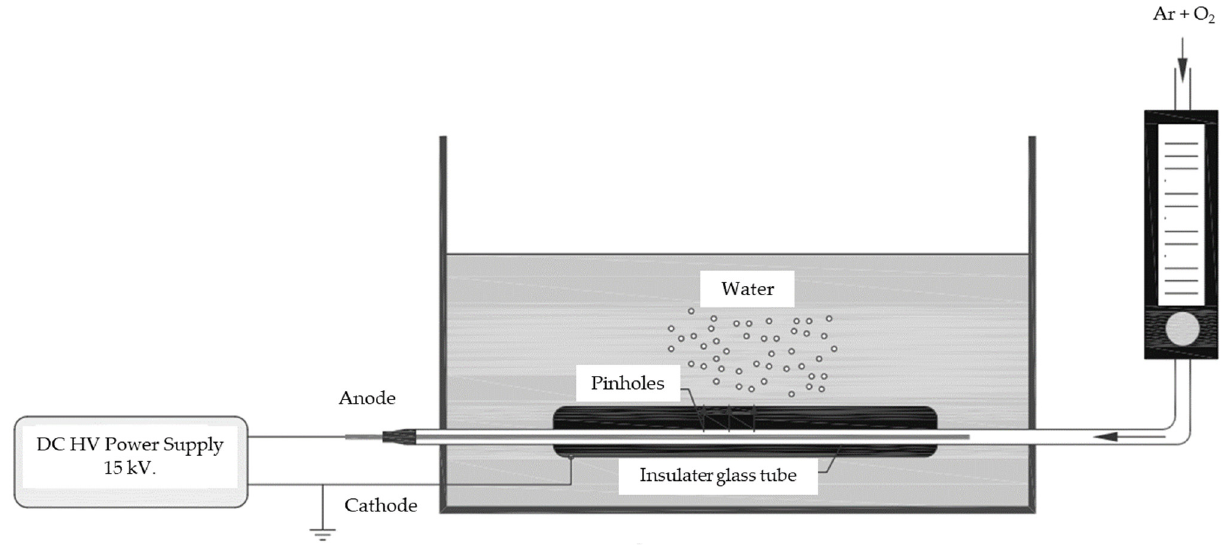
Figure 1. Schematic diagram of pinhole plasma jet PAW operating at atmospheric pressure.